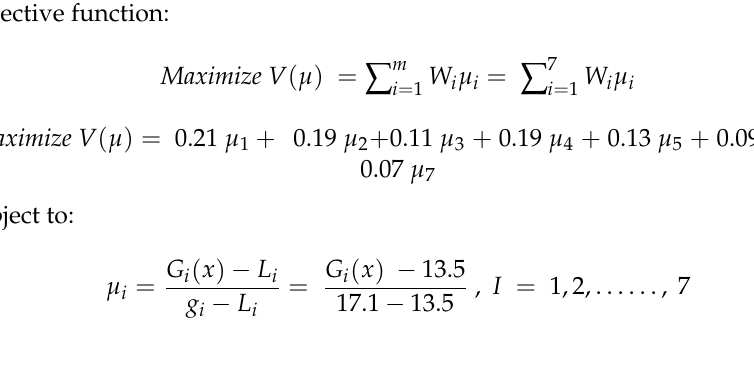
Fuzzy Goal Programming formulation model for optimization of smart clinic